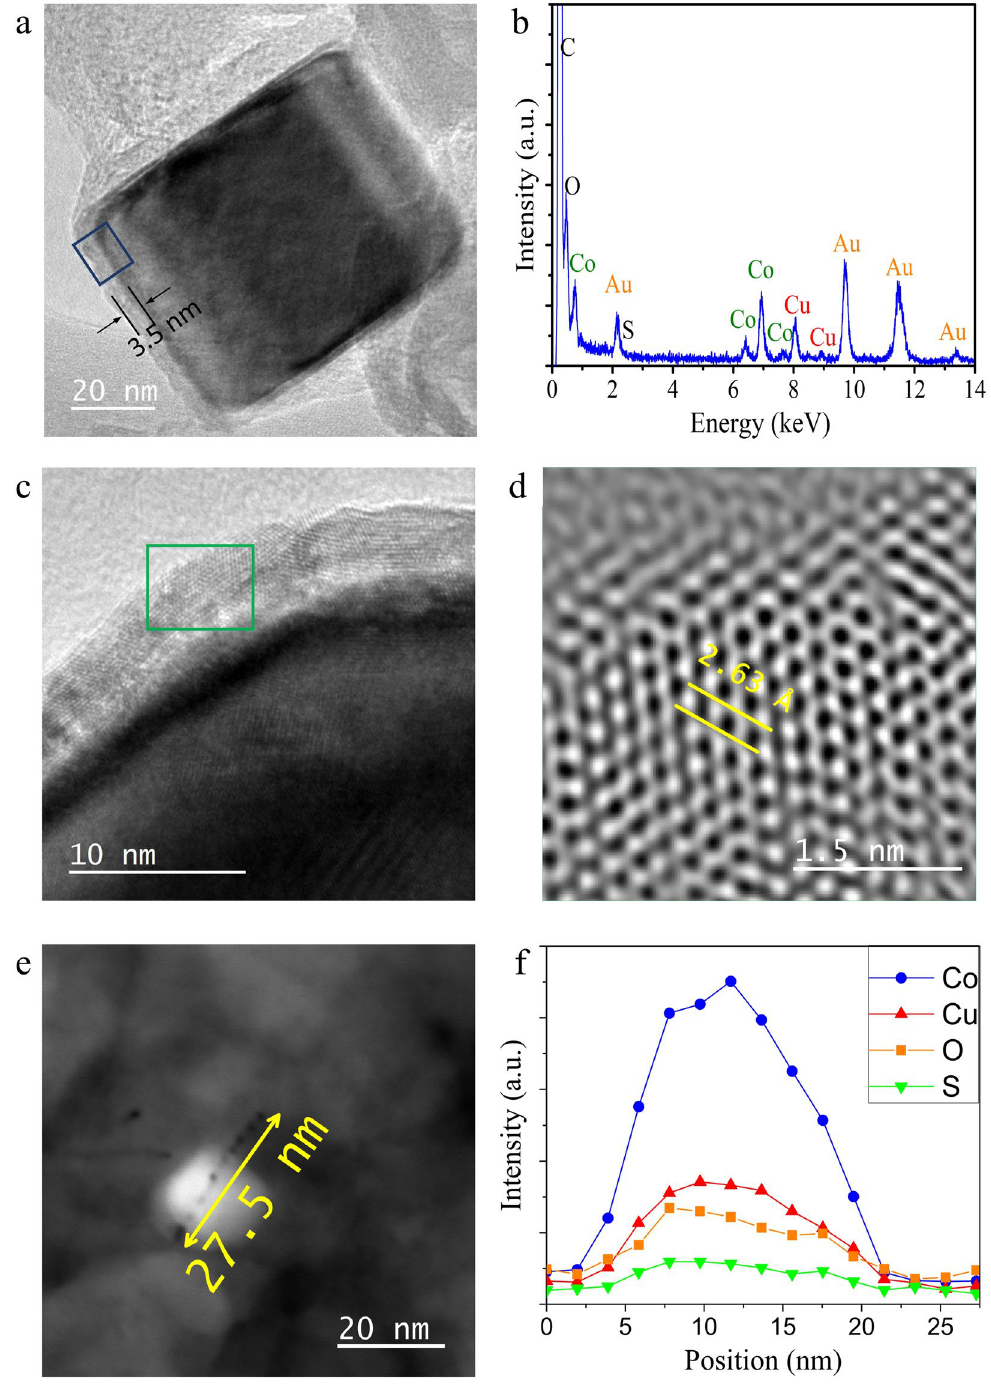
Figure 3. ( a ) HRTEM images of a catalytic Co-nanoparticle. ( b ) EDS analysis revealing the presence of Co, Cu, and O in the catalytic particle. ( c ) Few layers of copper oxide surrounding the Co nanoparticle. ( d ) FFT analysis on the region enclosed in ( c ) yielded an intelayer distance of 2.63 Å that correspond to the (012) crystallographic plane of cobalt-copper oxide. ( e ) Z-contrast TEM image of a Co nanoparticle of ~20 nm diameter and the corresponding elemental line-scan along the nanoparticle ( f ) revealing Co, Cu, O, and